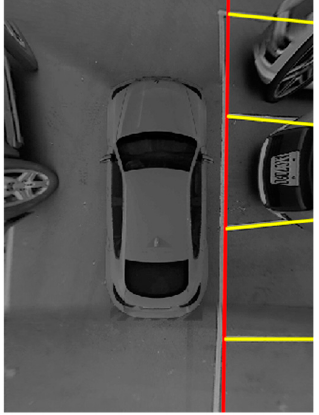
Figure 4. Characteristics of parking space markings.